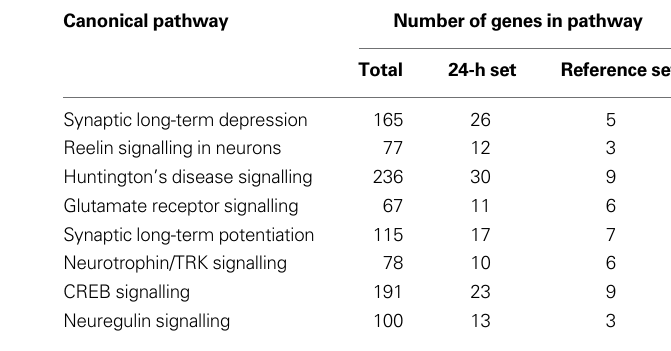
Table 4 | Representation of gene sets in IPA’s canonical pathways related to neurological functions or diseases. The pathways are ordered by their p -values which are computed using Fisher’s exact